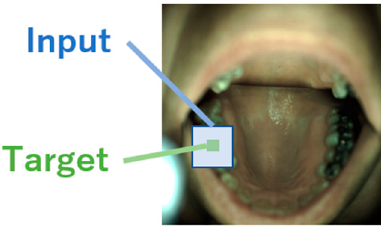
Figure 4. A sample of the target class for 5 × 5 patch images, adapted from the image of ODSI-DB [40] (CC BY-NC-SA 4.0).